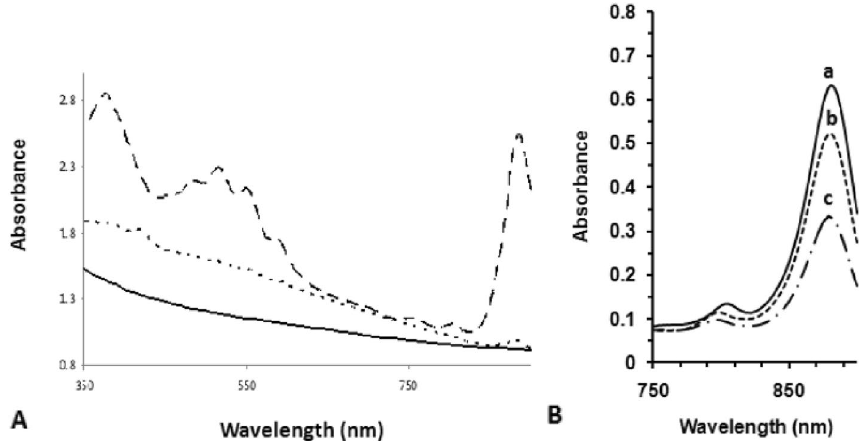
Fig. 3 Absorption spectra of whole cultures of Rsp. Rubrum . A Absorption spectra of whole cultures of the wild‑type strain of Rsp. rubrum grown phototrophically anaerobically (dashed line), chemophototrophically, grown aerobically (no photosynthetic membranes) (dotted line) and the mutant strain Rsp. rubrum REGO ‑ (solid line) grown anaerobically in the dark at 30 °C in presence of DMSO. B (a) Absorption spectrum of whole culture of wild‑type strain of Rsp. rubrum grown phototrophically. (b) Absorption spectrum of Rsp. rubrum of the complementation strpRK‑REGO grown phototrophically is also shown. (c) Wild‑type Rsp. rubrum grown chemophototrophically in presence of DMSO as an external electron acceptor